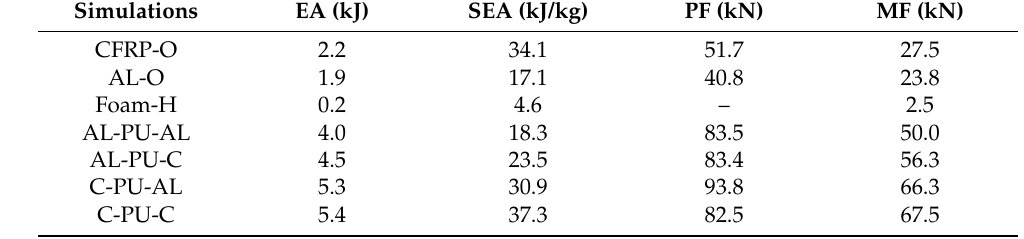
Table 5. Summary of standard deviations of single tubes and hybrid structures obtained from the experiment and simulation results.